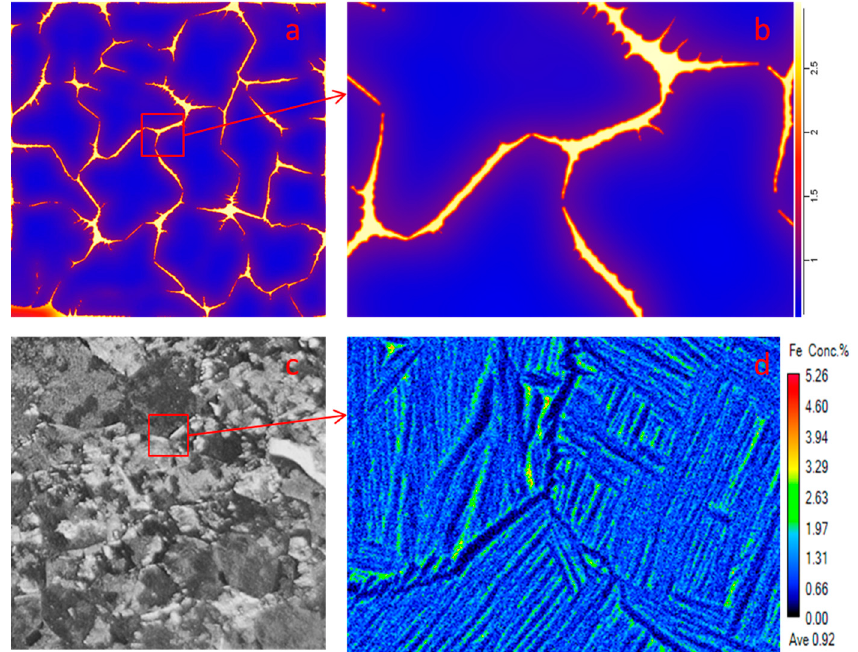
Figure 12. Comparison of simulated and experimental values of Fe concentration in Ti–6Al–4V–0.9Fe alloy. ( a ) Selection of simulation position, ( b ) Simulated value of Fe concentration, ( c ) Selection of experimental position, ( d ) Experimental value of Fe concentration.